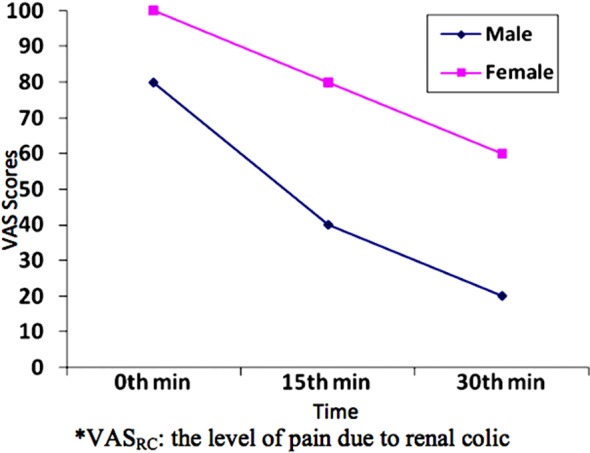
The changes in the VASRC scores for patient group at 0, 15 and 30th min*.